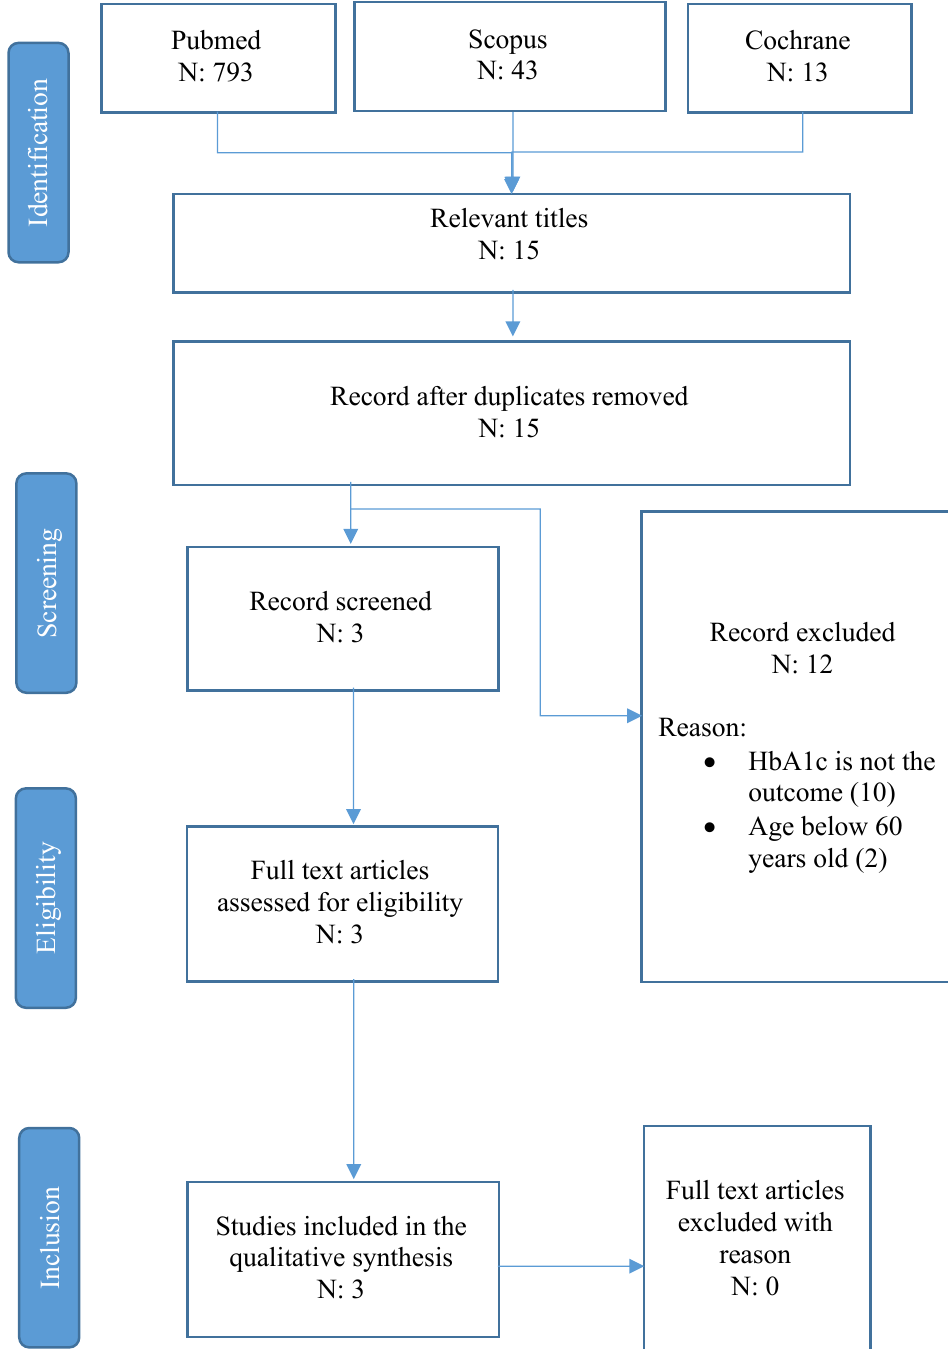
Figure 1 . Prima’s flow chart of literature